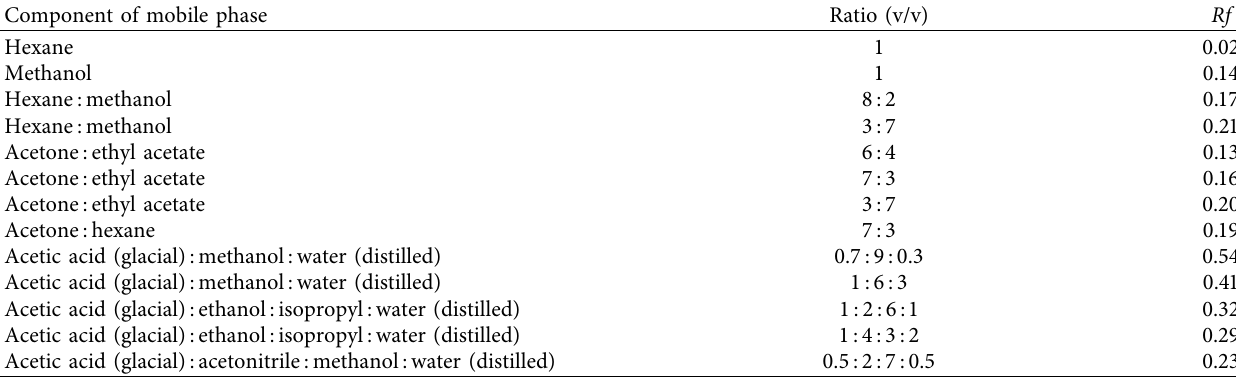
Table 1: Component of mobile phase used in TLC analysis of B. vulgaris L. peels and pomaces. Component of mobile